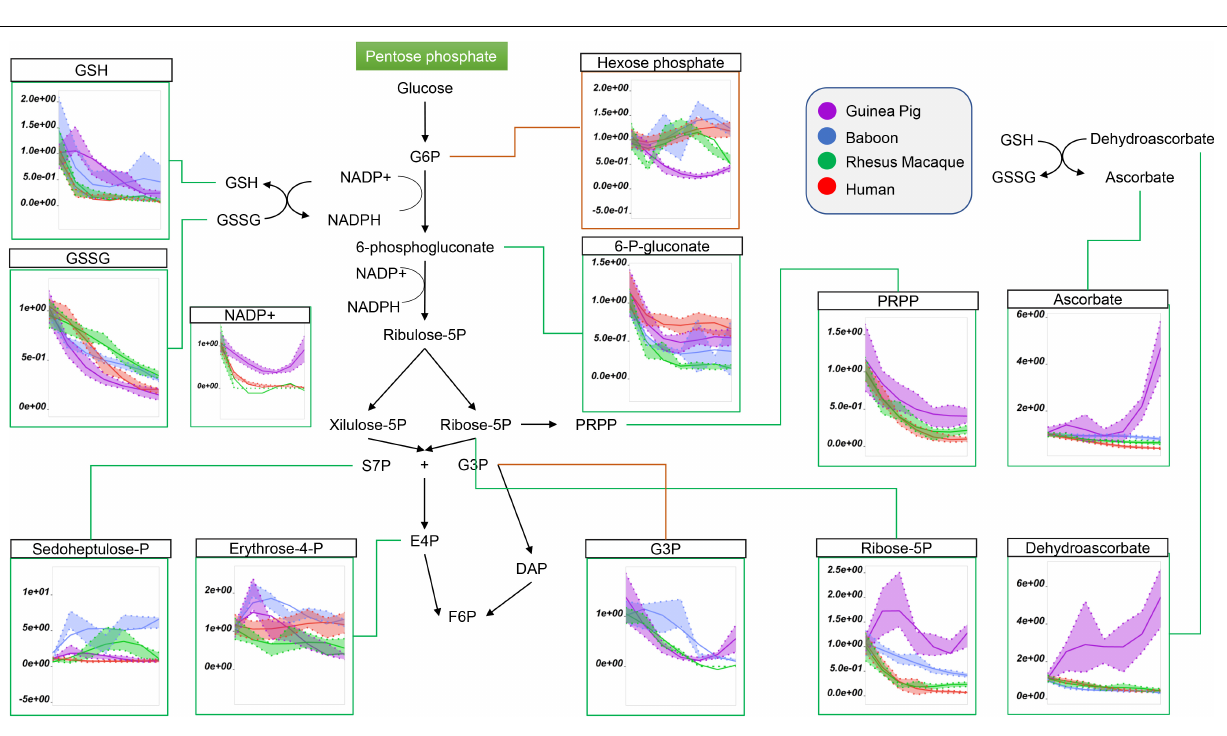
FIGURE 3 | Impact of storage on the pentose phosphate pathway, and on glutathione and ascorbate metabolites in stored RBCs from guinea pigs (violet), baboons (blue), rhesus macaques (green), and humans (red). Line plots indicate metabolite medians (lighter colored areas are ranges) normalized to measurements in fresh, non-stored blood (day 0) and autoscale normalized across groups. All metabolites are significant by ANOVA (FDR corrected– p <